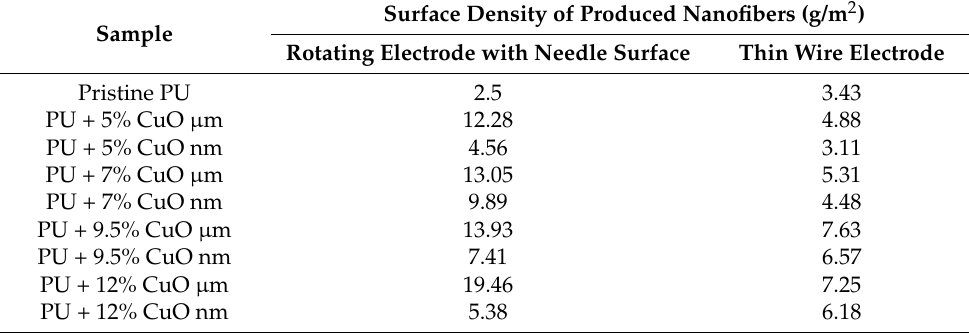
Table 4. Results of measurements of the surface density for nanofibrous layers with micro- and nanoscale CuO produced from the rotating needle electrode and wire electrode.